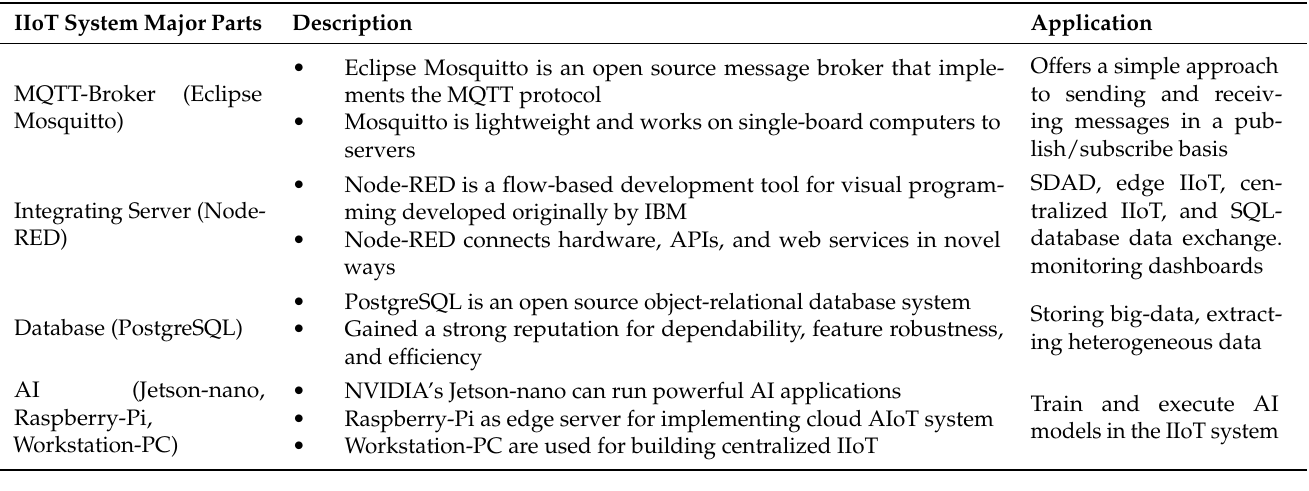
Table 1. Major parts of the proposed IIoT infrastructure.